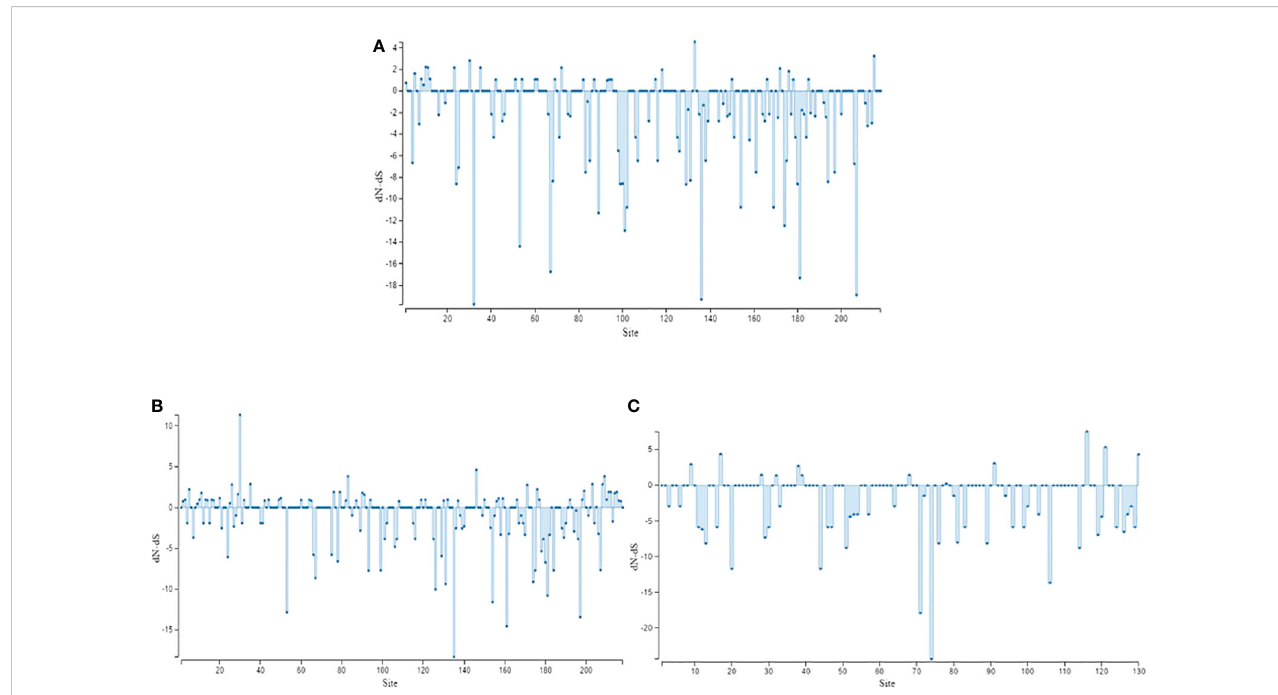
FIGURE 2 Selection analyses for AMV populations by DnaSP version 5. (A) Chinese population; (B) Iranian population; (C) Spanish